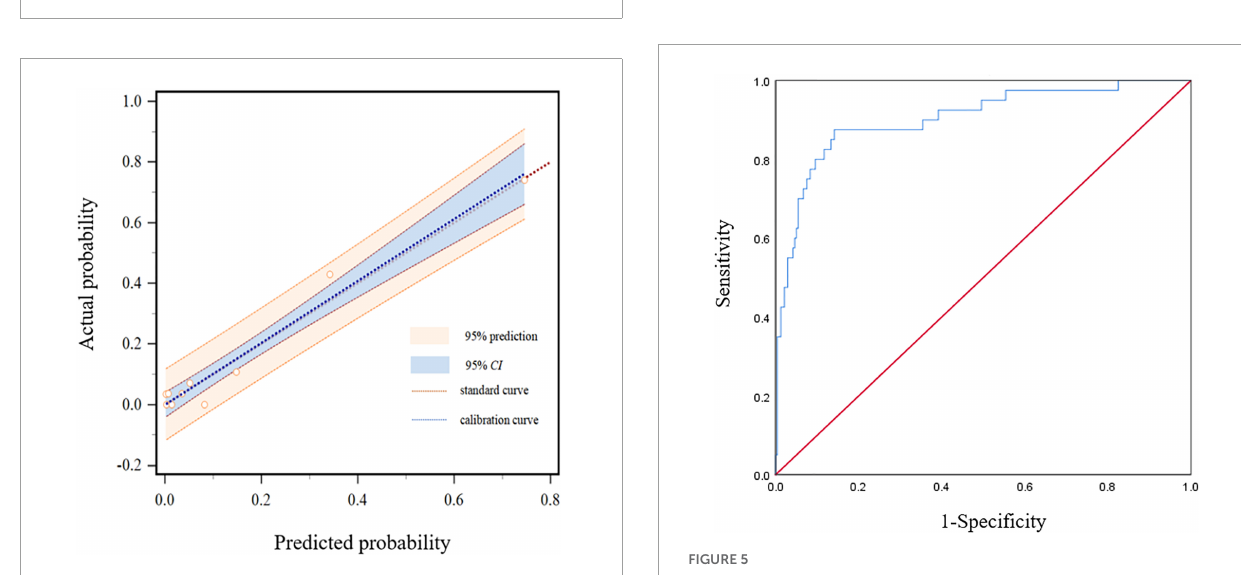
FIGURE3 Prediction model formula.